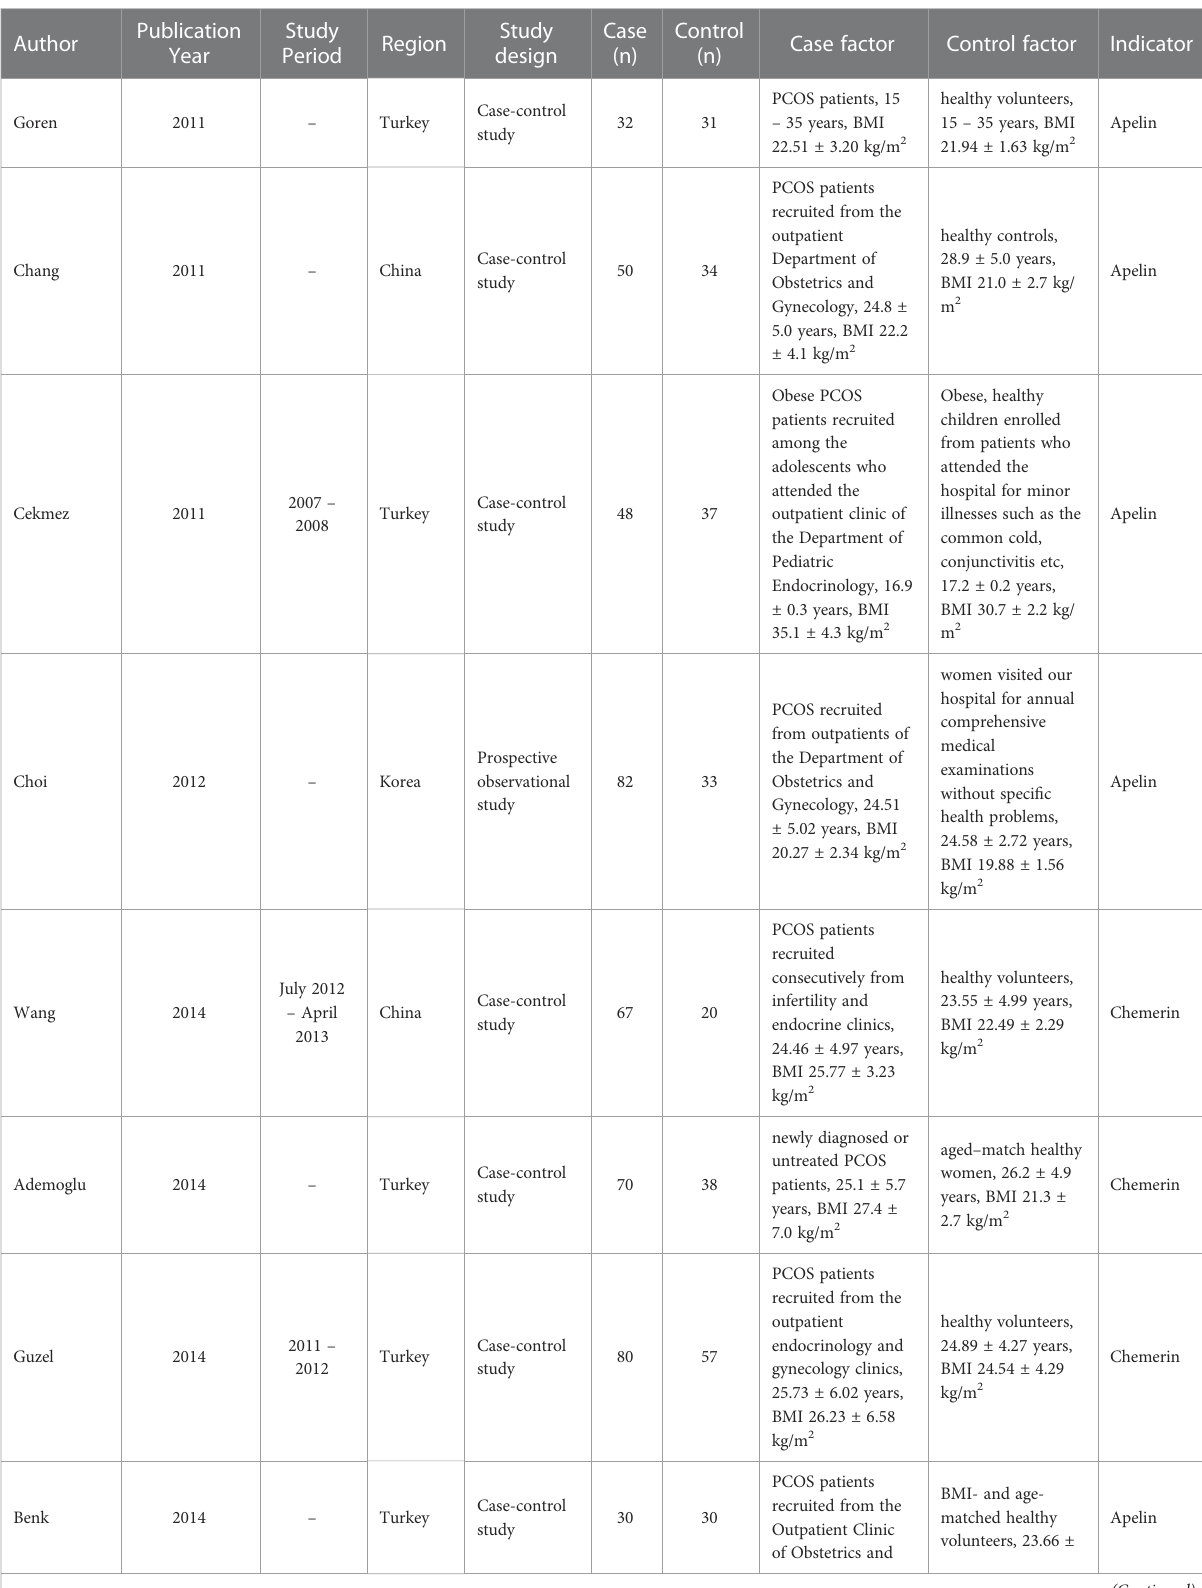
TABLE 1 Study characteristics of the published studies included in the